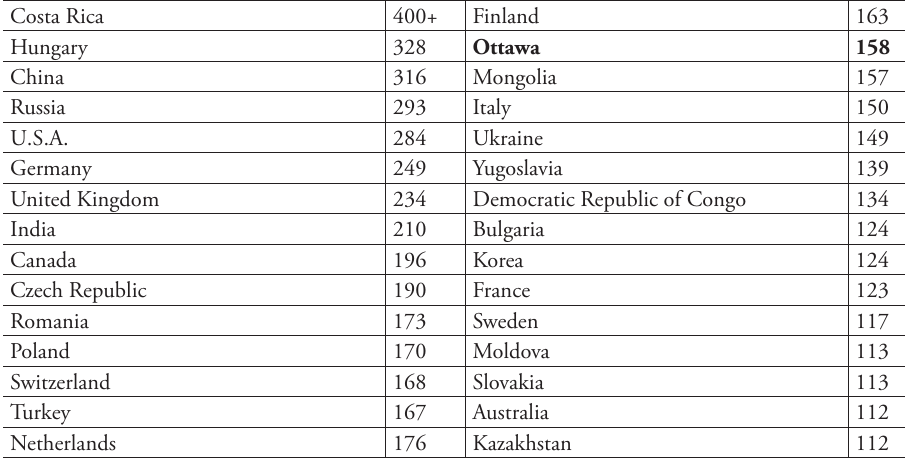
Table 1. Microgastrinae diversity by country with over 100 species recorded. Data from Taxapad (Yu et al. 2012), Fauna Europaea (http://www.fauna-eu.org/) and the present paper (for Canada and Ottawa). For Costa Rica the total is a very conservative estimate based on numerous papers published after 2012 on the fauna of Area de Conservación Guanacaste